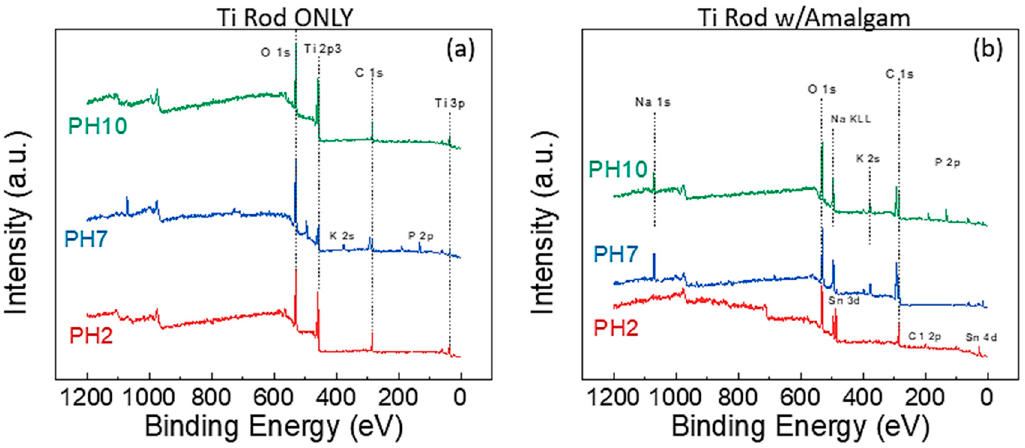
Figure 2. XPS survey spectra of ( a ) Ti rods submerged in various solutions without amalgam and ( b ) Ti rods submerged in various solutions with amalgam.